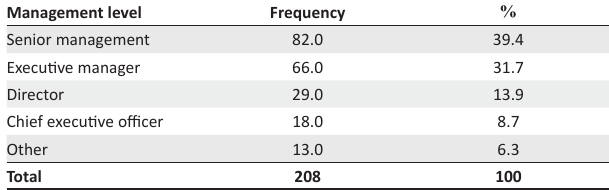
TABLE 7: Characteristic three: Management level of respondents.